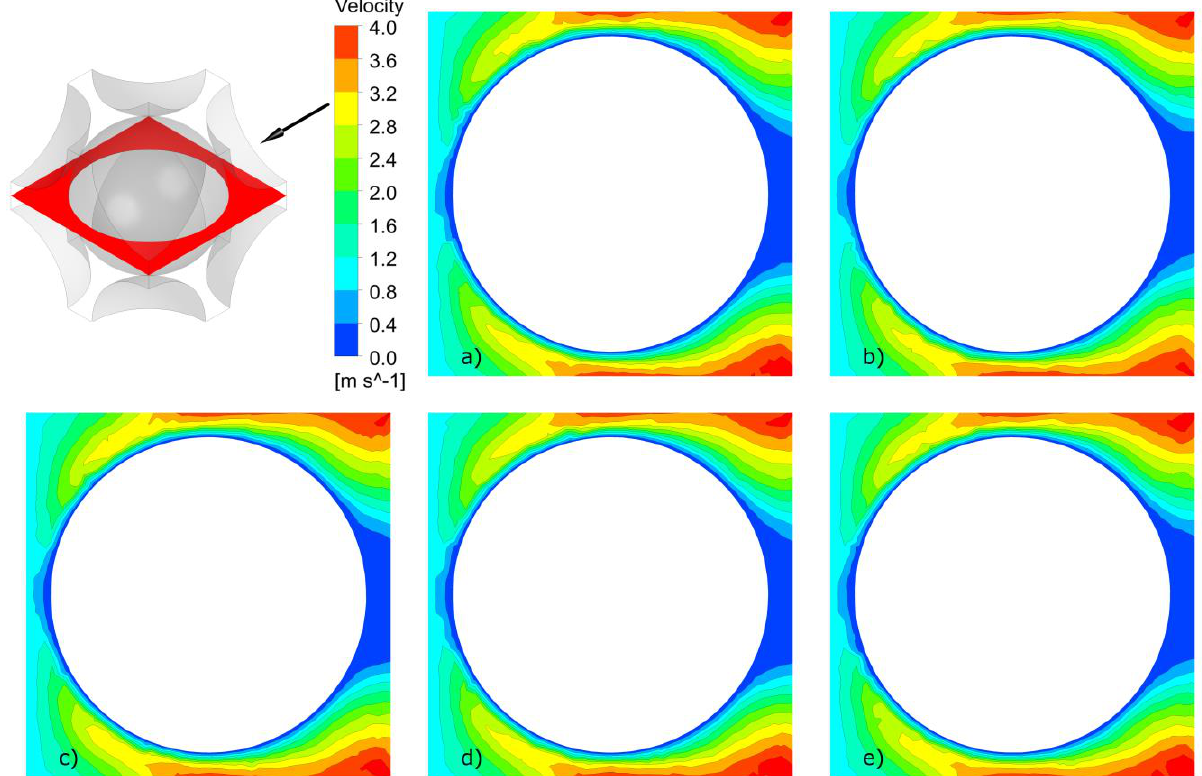
Fig. 13. Velocity magnitude on XZ plane obtained with the discretization method with additional cylindrical volumes R cyl% equal: a – 5.00%. b – 6.25%. c – 7.50%. d – 8.75%. e - 20.00%.